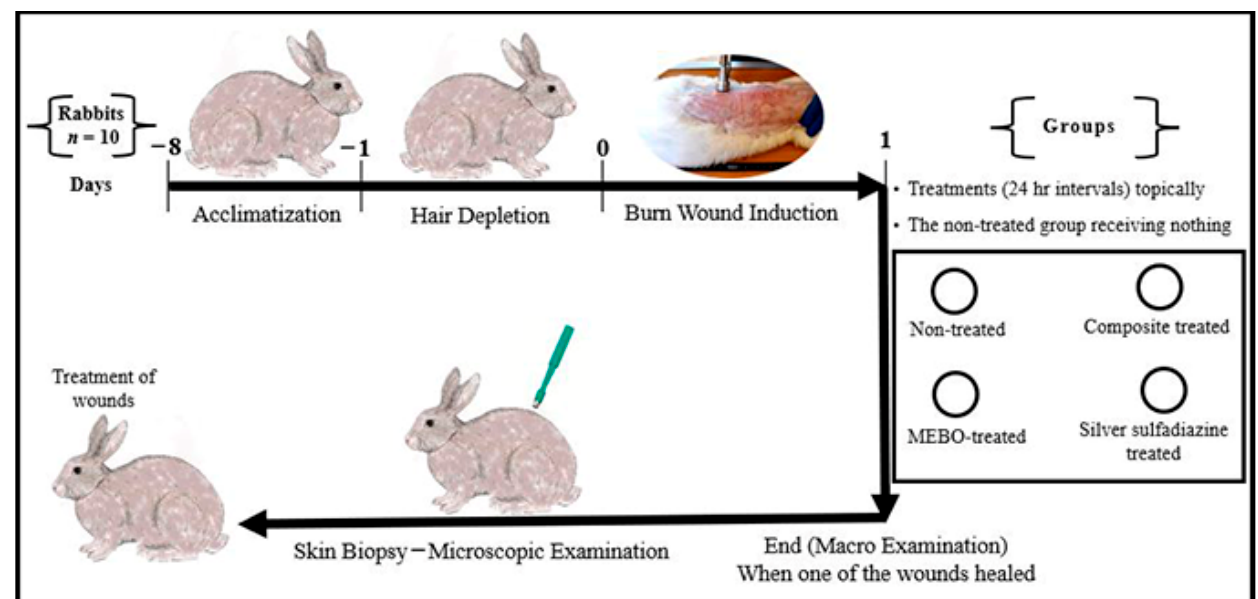
Figure 1. Infograph representing the experimental design. Acclimatization was continued for one week. Hair depletion was done using Veet™ cream topically for three minutes. Burn wound induction was done under the effect of general anaesthesia, four burn-wounds were created by aluminum stamp (80 °C/14 s) on the back of the animal using electronic thermal aluminum stamp represents one of the following treatment groups; non-treated group, natural composite treated group, MEBO ® cream treated group, and silver sulfadiazine ® cream treated group, respectively. Skin biopsies were collected from the central part of the wounds using disposable skin biopsy punches 10 mm under the effect of general anaesthesia.